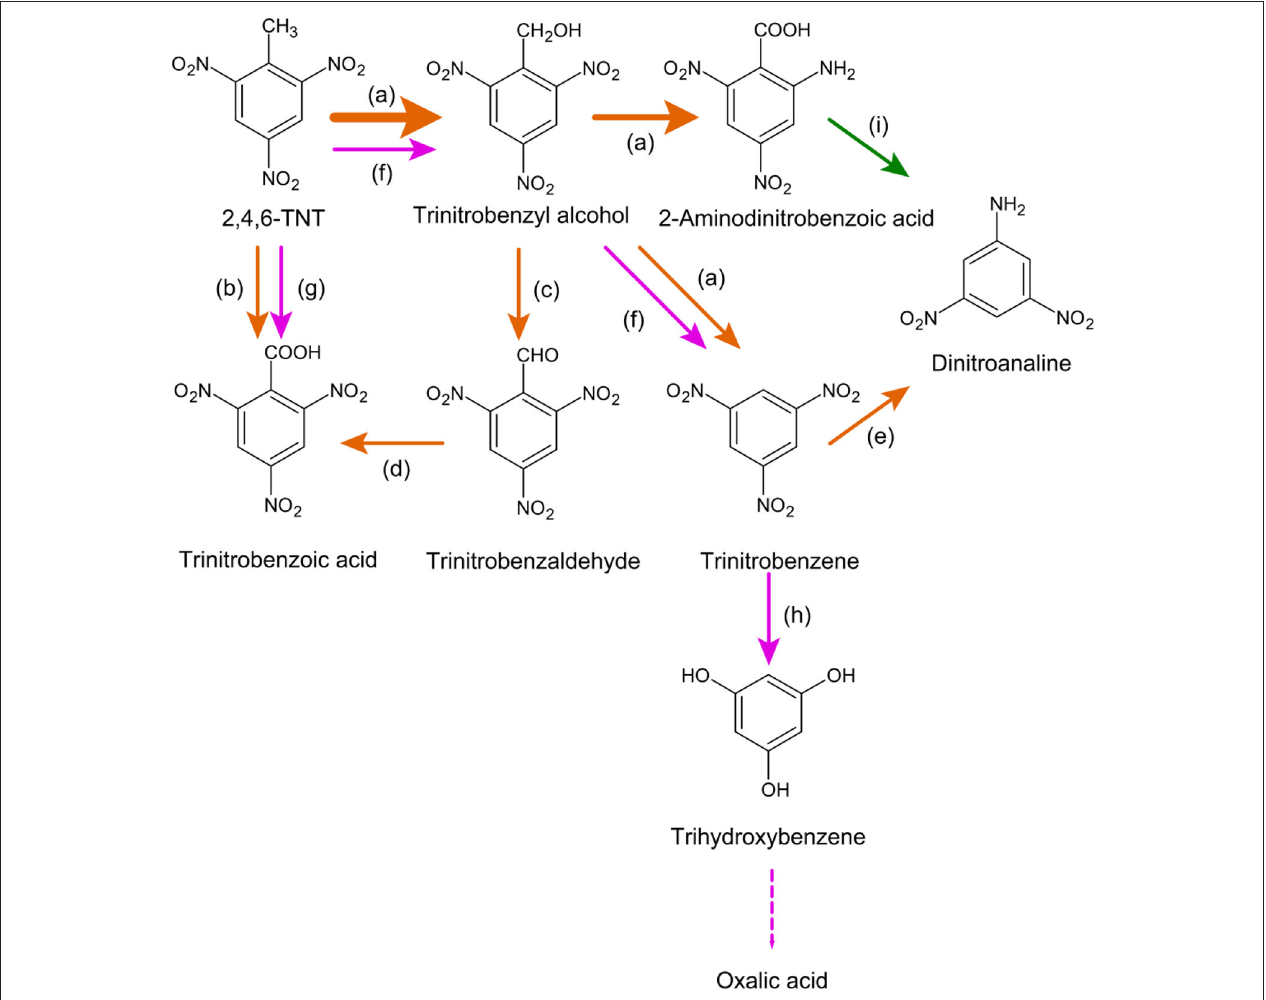
FIGURE 8 | TNT transformation and mineralization via photo- and Fenton- reaction. Symbols as in Figure 6 . References: a, Spanggord et al. (1983), Godejohann et al. (1998) , Luning Prak et al. (2017), and Burlinson et al. (1979a); b, Luning Prak et al. (2017) and Burlinson et al. (1979a); c, Luning Prak et al. (2017); d, Godejohann et al. (1998), Kaplan et al. (1975), and Schmelling and Gray (1995); e, Spanggord et al. (1983) and Godejohann et al. (1998); f, Jarand et al. (2011) and Hess et al. (2003); g, Hess et al. (2003); h, Hess et al. (2003), Liou et al. (2003), and Li et al. (1998); i, Spanggord et al. (1983) and Godejohann et al.